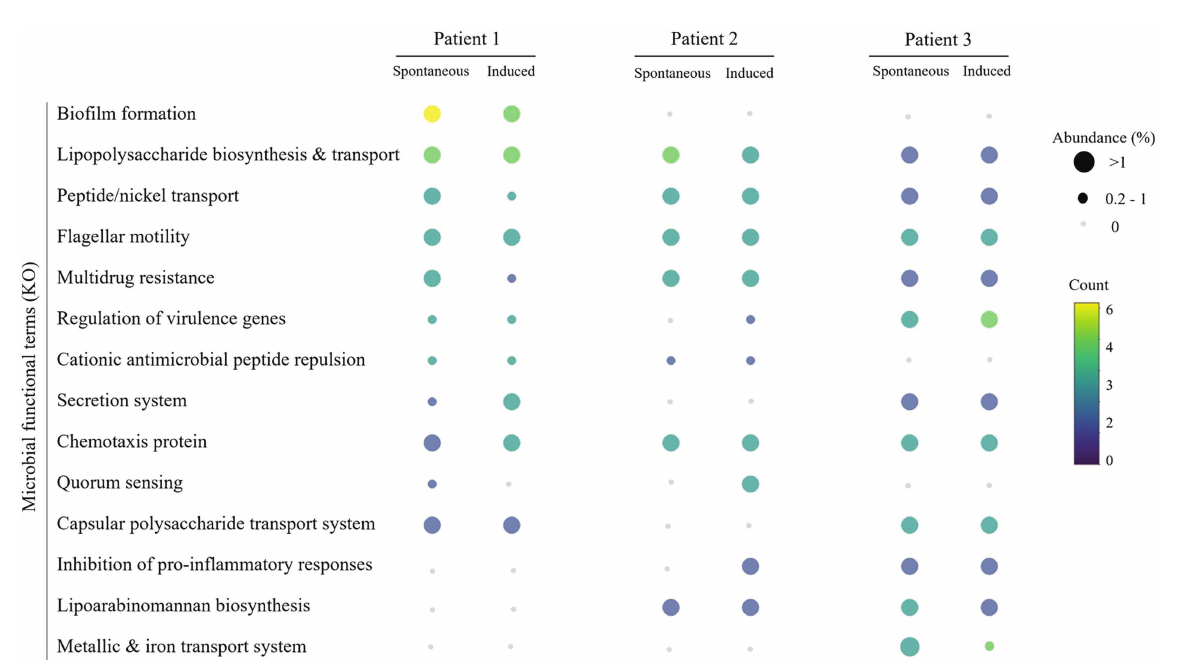
FIGURE 5 Functional annotation of the microbial proteins found in spontaneous and induced sputum samples. The relative abundance of each category corresponds to the sum of the relative abundance of each KEGG Orthology (KO) term of interest of the related category, which is indicated by the size of the dot. The color scale corresponds to the number of KO terms of interest involved in each